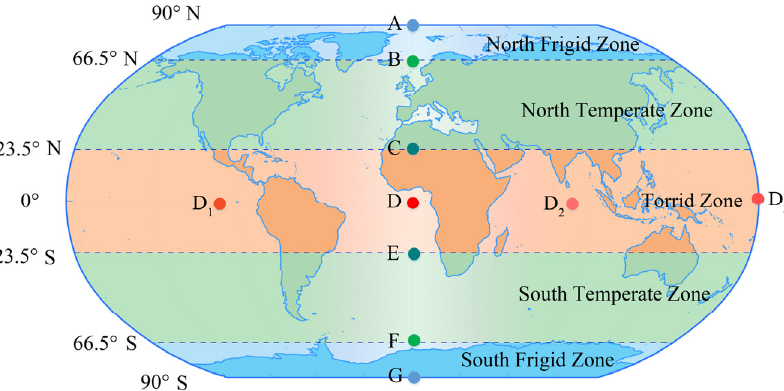
Figure 3. Distribution of selected observed points. Points A (90 ◦ N, 0 ◦ ) and G (90 ◦ S, 0 ◦ ) are at the North and South poles, respectively; Points B (66.5 ◦ N, 0 ◦ ) and F (66.5 ◦ S, 0 ◦ ) are on the Arctic Circle and Antarctic Circle, respectively, which are the boundaries between the frigid and temperate zones. Their latitude is the complementary angle of the obliquity of the ecliptic. Points C (23.5 ◦ N, 0 ◦ ) and E (23.5 ◦ S, 0 ◦ ) are located on the Tropic of Cancer and Tropic of Capricorn, which are the boundary lines between the temperate zone and tropics. Point D (0 ◦ , 0 ◦ ) is on the equator. Points D 1 (0 ◦ , 90 ◦ W), D 2 (0 ◦ , 90 ◦ E) and D 3 (0 ◦ , 180 ◦ E) are at different longitudes on the equator.